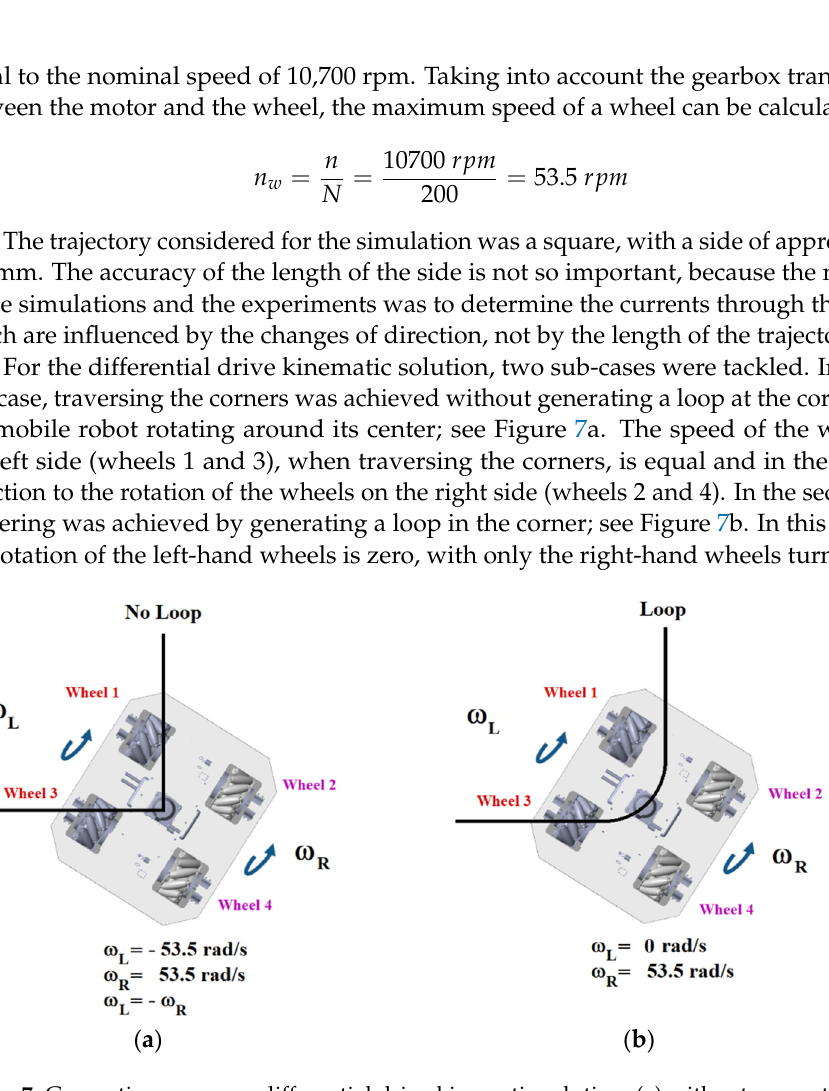
Figure 7. Generating corners—differential drive kinematic solution: ( a ) without generating a loop; ( b ) generating a loop.